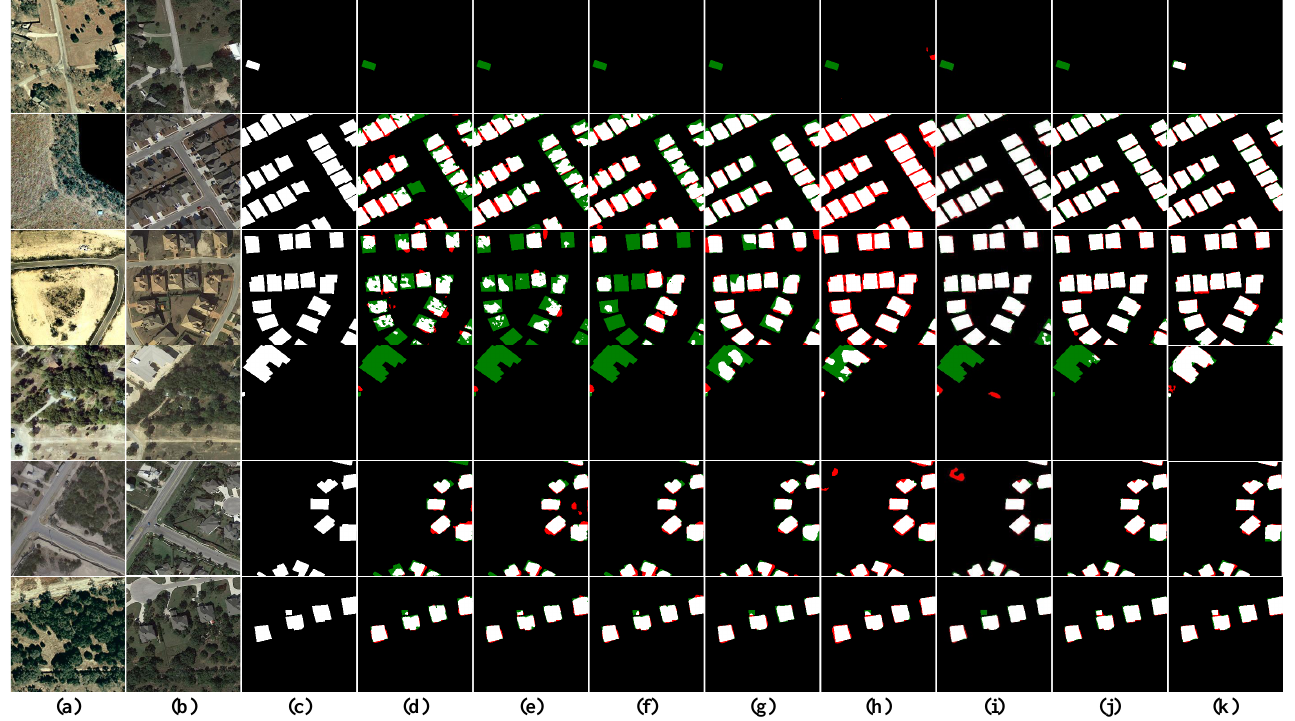
Figure 10. Visualization results on the LEVIR-CD dataset. ( a ) T1 images. ( b ) T2 images. ( c ) Ground Truth. ( d ) FC-EF. ( e ) FC-Siam-conc. ( f ) FC-Siam-diff. ( g ) CDNet. ( h ) STANet. ( i ) BIT. ( j ) SNUNet. ( k ) Ours. White indicates correctly detected changed areas, black indicates correctly detected un- changed areas, red indicates incorrectly detected unchanged areas as changed areas, and green indicates unpredicted changed